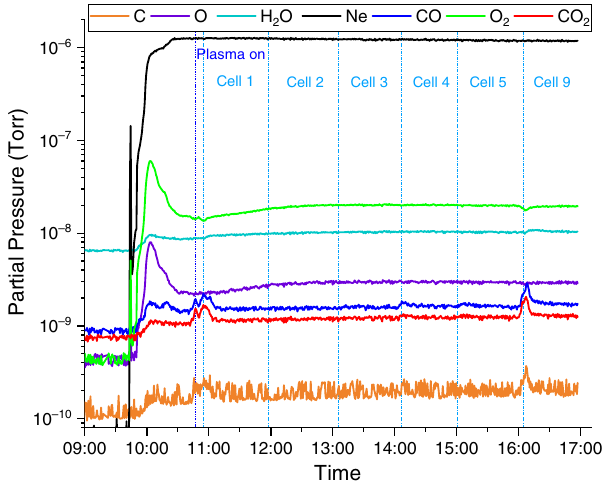
FIG. 6. Plot of RGA signals measured on CAV1, during the first day of plasma processing from cell no. 1 to no. 5 and cell no. 9. As the gas flow is started and the pressure in the vCM increases, there is an initial peak in the oxygen signals (at 16 and 32 amu), which then decreases and stabilizes to ≈ 1 . 6% of the neon content. The partial pressures measured by the RGA differ from the total pressure in the cavity string since the RGA is positioned on a bypass line near a turbo pump on the vacuum cart to allow the RGA filament to sample the gas composition. A leak valve is used to regulate the gas flow through the